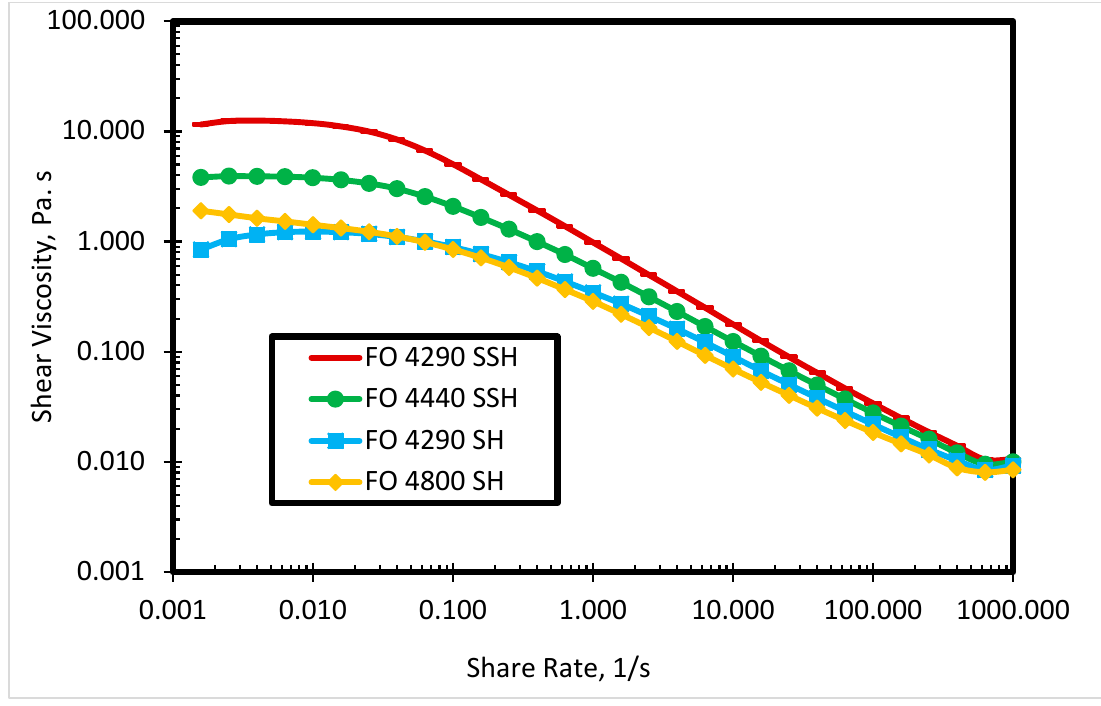
Figure 2. Shear viscosity of commercial polymers in deionized water.